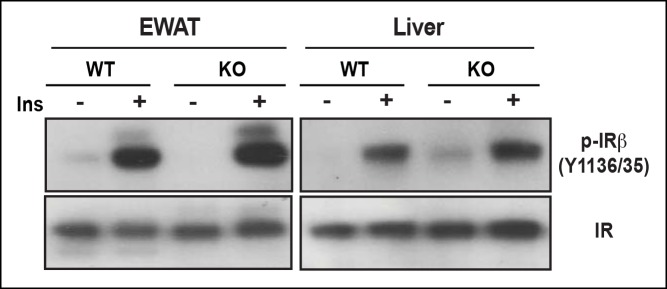
EWAT insulin sensitivity determined by IR tyrosine phosphorylation.After 14-week of HFD, IR from both WT and PDZ-RhoGEF KO EWAT and liver remained sensitive to insulin, determined by IR tyrosine phosphorylation.